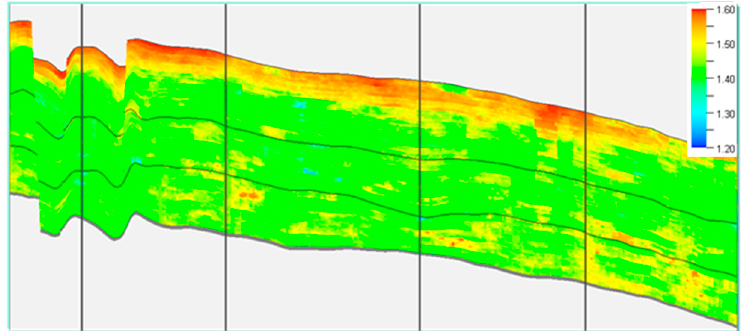
Figure 5. Cross-section map of the pore pressure coefficient in the N–S direction.